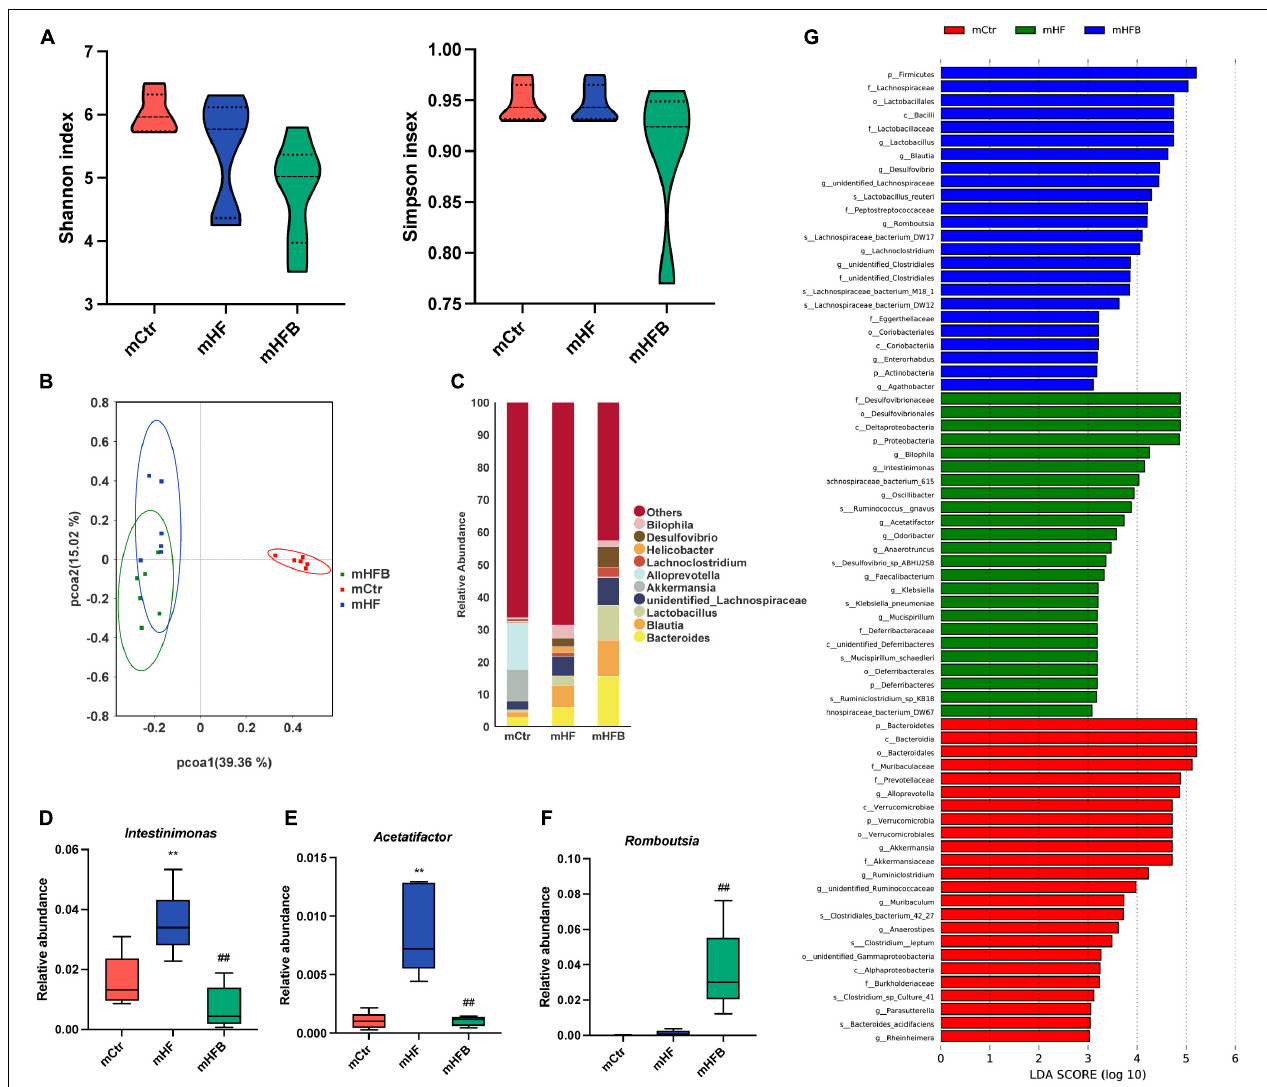
FIGURE 2 | Betaine alters the gut microbiota in high-fat diet dams. The cecal contents were collected from dams after weaning. (A) Shannon index (left) and Simpson index (right); (B) PCoA plots of gut microbiome; (C) relative abundance of the top 10 species at the genus level; (D) relative abundance of Intestinimonas ; (E) relative abundance of Acetatifactor ; (F) relative abundance of Romboutsia ; (G) distinct taxa identified in the three groups using LEfSe analysis. The colors represent the group in which the indicated taxa is more abundant compared to the other group. Ctr, standard control diet; HF, high-fat diet; HFB, high-fat diet with betaine. Data are expressed as means ± S.E.M. ( n = 4–6/group). One-way ANOVA; ** p < 0.01 vs. Ctr, ## p < 0.01 vs.